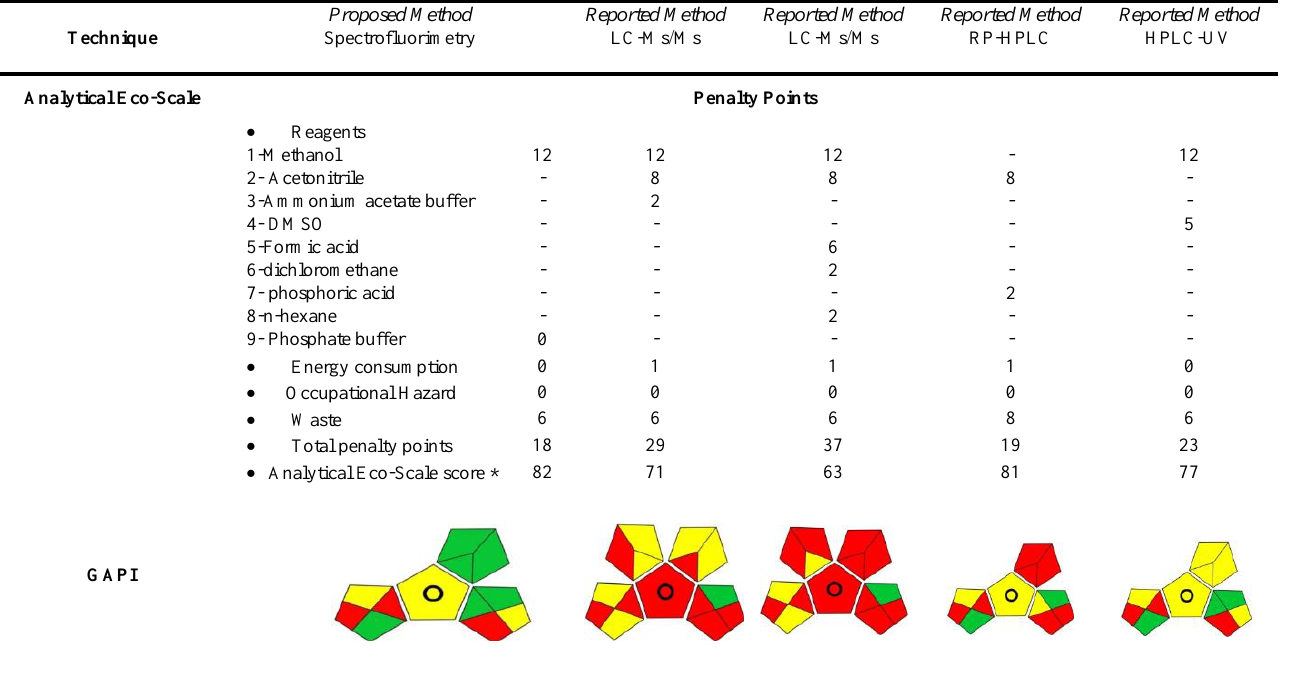
Table 6. Greenness assessment of the proposed and reported methods using Analytical Eco-Scale and GAPI